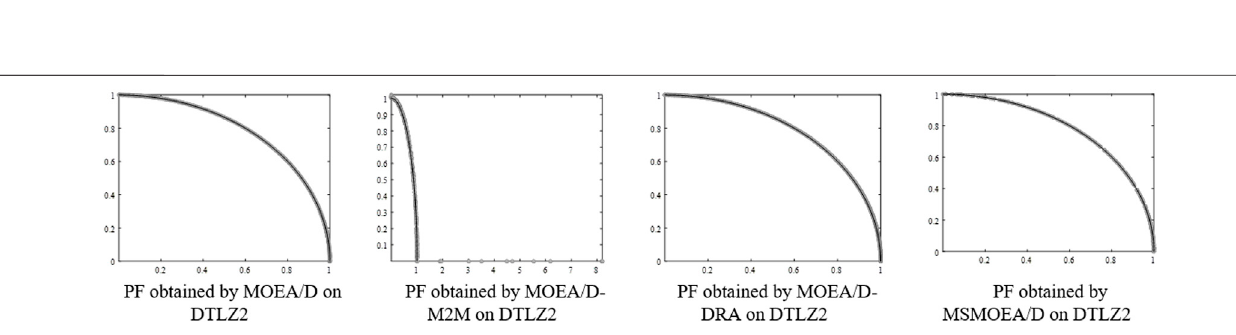
FIGURE 5 | PF obtained by MSMOEA/D and MOEAs on two-objective DTLZ2.